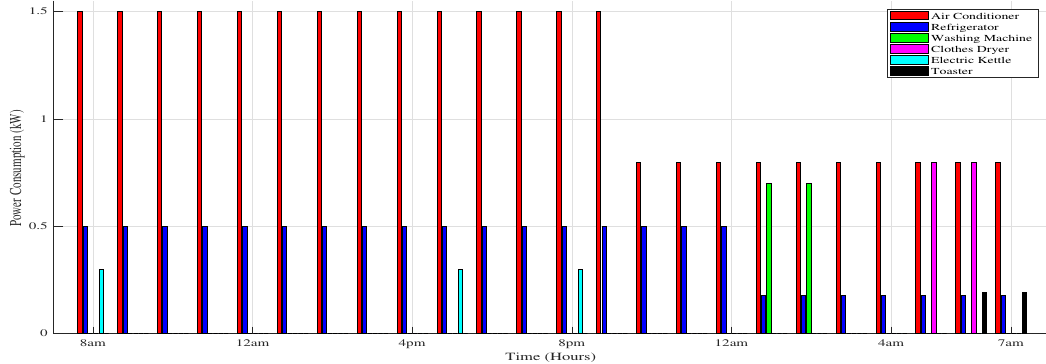
Figure 5. Power consumption of appliances.